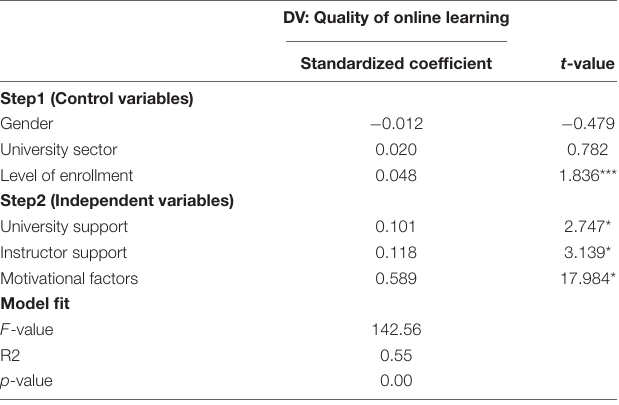
TABLE 6 | Stepwise linear regression.